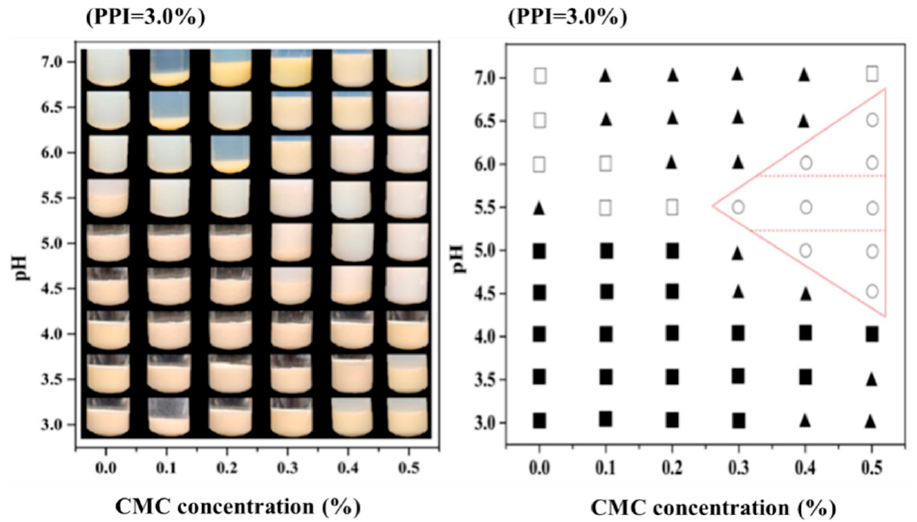
Figure 1. Phase diagram of pea protein isolate- carboxymethylcellulose (PPI-CMC) solutions at different pH and CMC concentrations with PPI concentration of 3.0% ( □ translucent solution; ○ cloudy solution; ▲ precipitation and cloudy solution; ■ precipitation and clear solution). The labeled areas mean intermediate narrow region appeared cloudy solutions without precipitate.